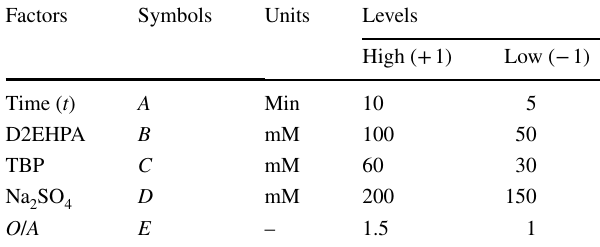
Table 1 Design matrix applied in 2 6-1 factorial design Factors Symbols